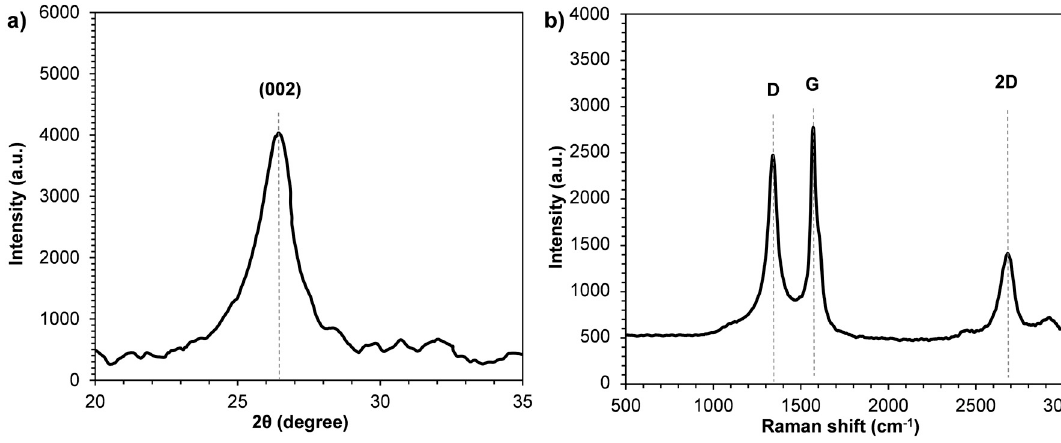
Figure 2. ( a ) X-Ray Diffraction ( XRD) pattern and ( b ) Raman spectrum of neat GnP powder.